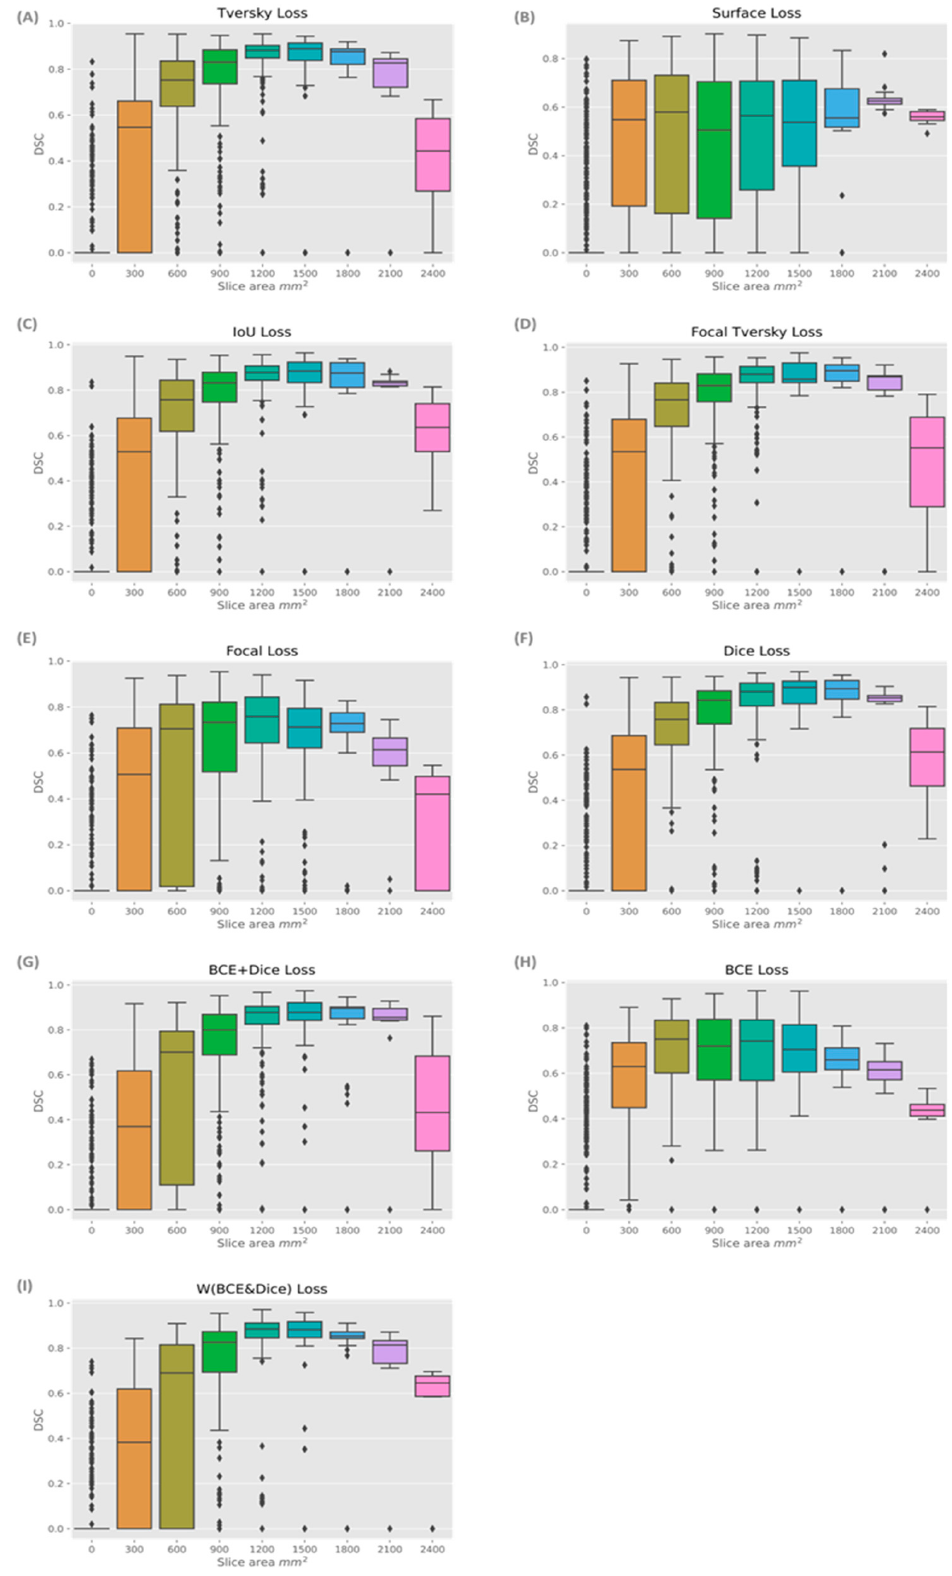
Figure 6. Box plots of DSC score vs. prostate area for each of the nine loss functions (A-I) listed in Table 1. DSC: Dice similarity coe ffi cient. Table 1. DSC: Dice similarity